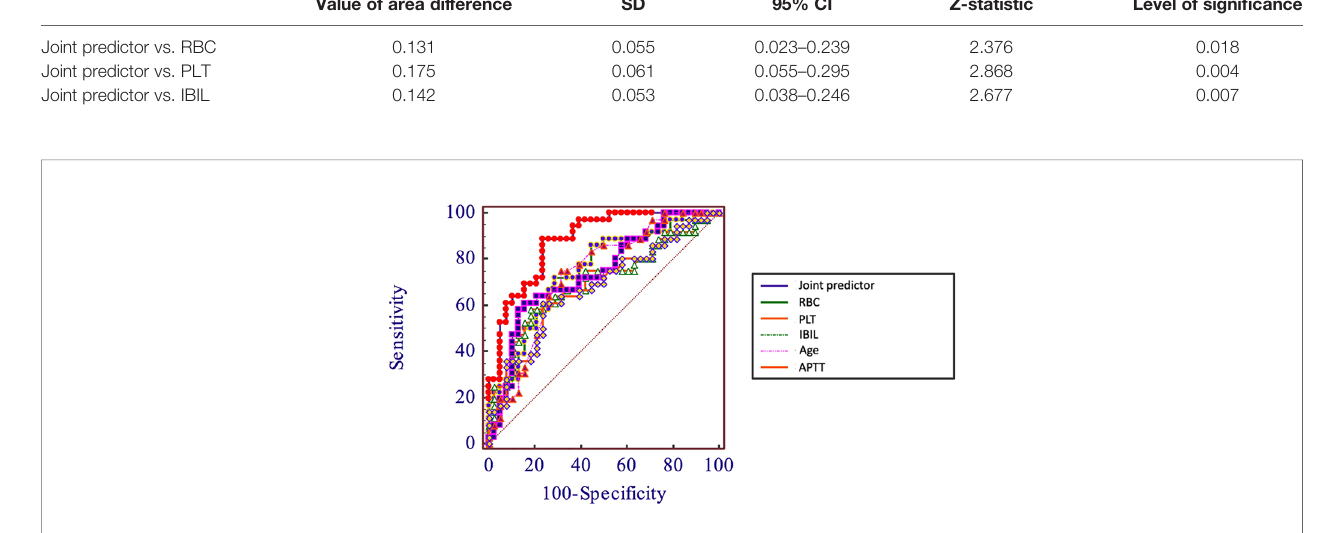
FIGURE 3 | Comparison between joint predictor and other single